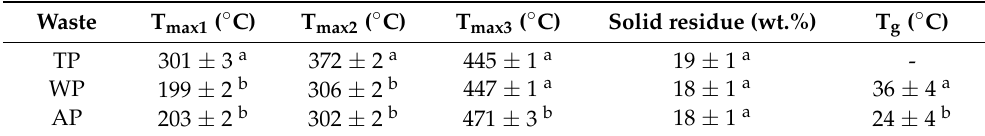
Table 6. Thermal results obtained for cutin derived from different peel wastes ( n = 3) Means ± SD. Different superscripts in the same column indicate significantly different values ( p <